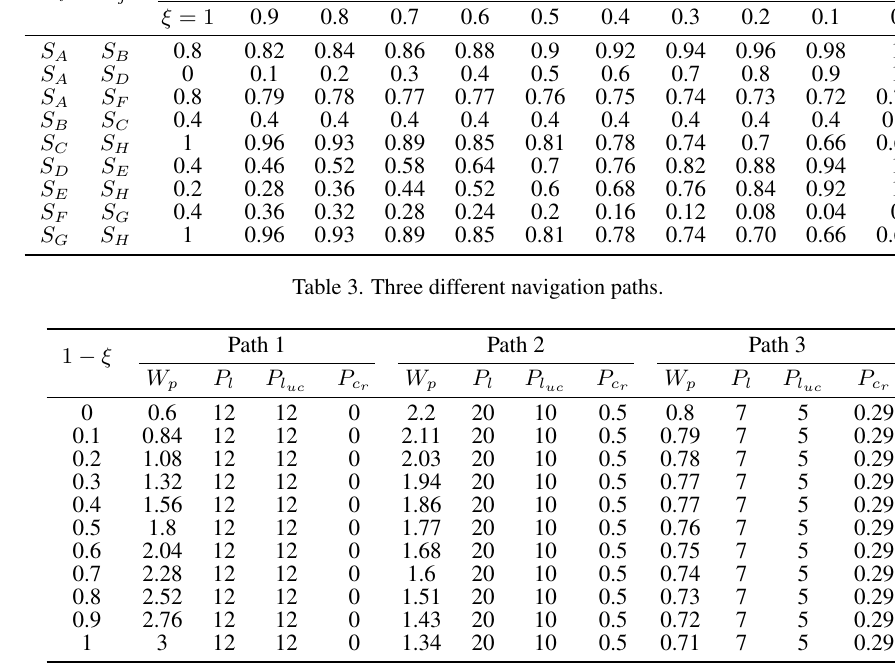
Table 2. Modified weights ( W (cid:48)(cid:48)